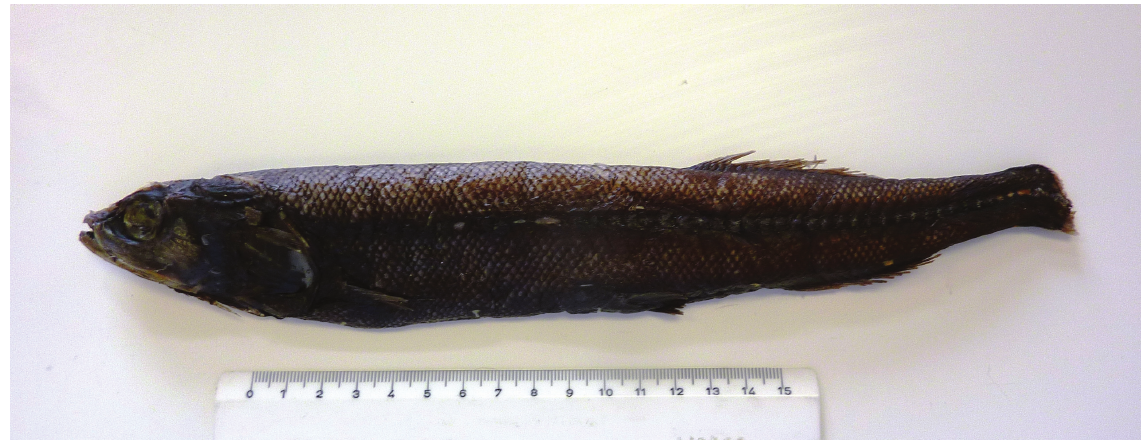
Fig. 2. Bajacalifornia megalops (Lütken, 1898)